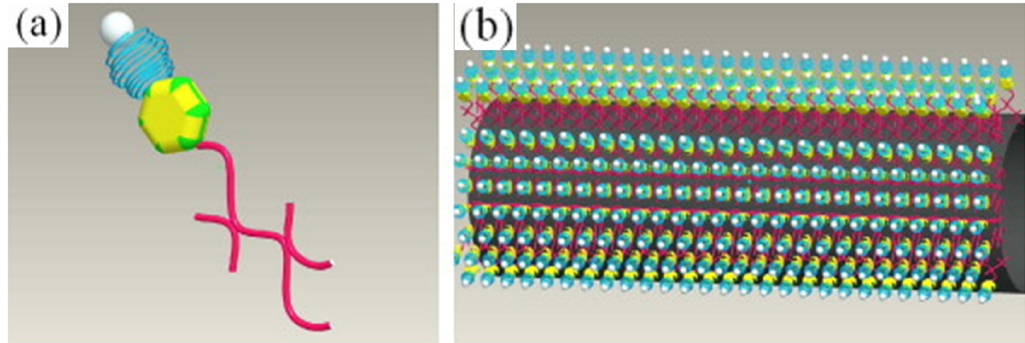
Figure 7. Functionalization of a CNF with the Triton X-100 ™ surfactant: ( a ) single molecule with hydrophilic head (top) and hydrophobic tail (bottom); and ( b ) formation of a uniform hydrophilic layer around the individual CNF [141].